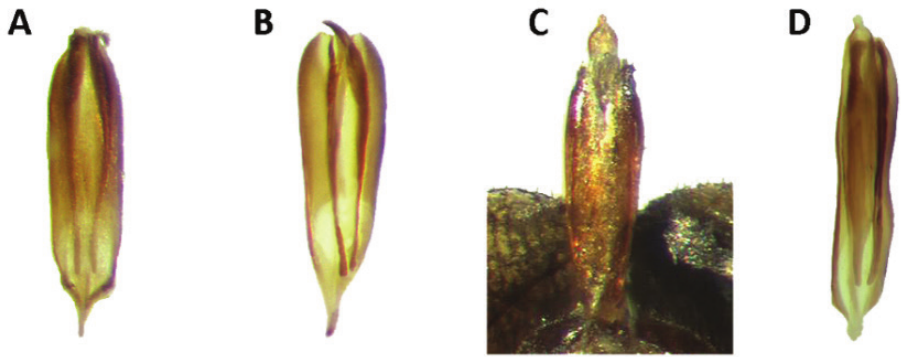
Figure 15. Aedeagus of: A Neocallotillus elegans ( black morph ) B Neocallotillus elegans ( bi-colored morph ) C Neocallotillus intricatus D Callotillus eburneocinctus.